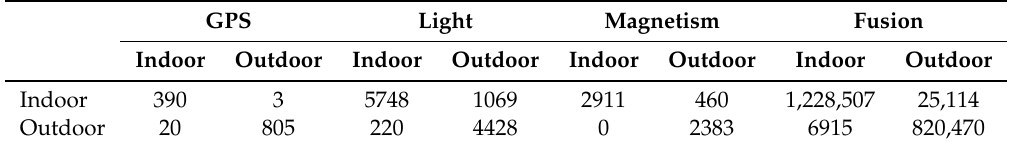
Table 5. Confusion matrix of Building II.